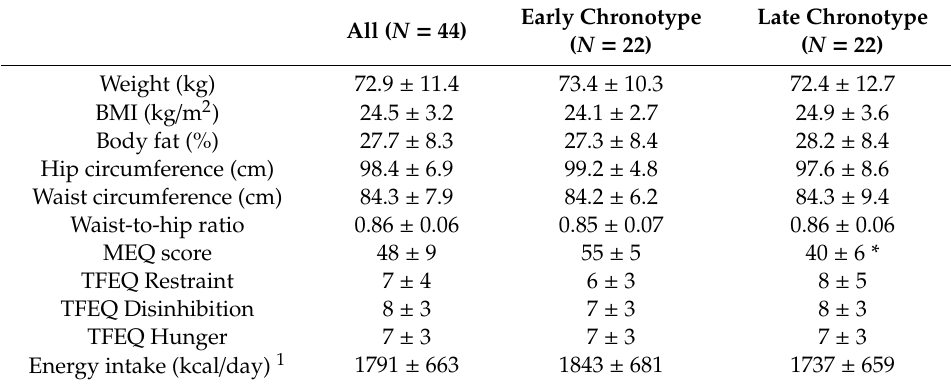
Table 2. Participant characteristics.